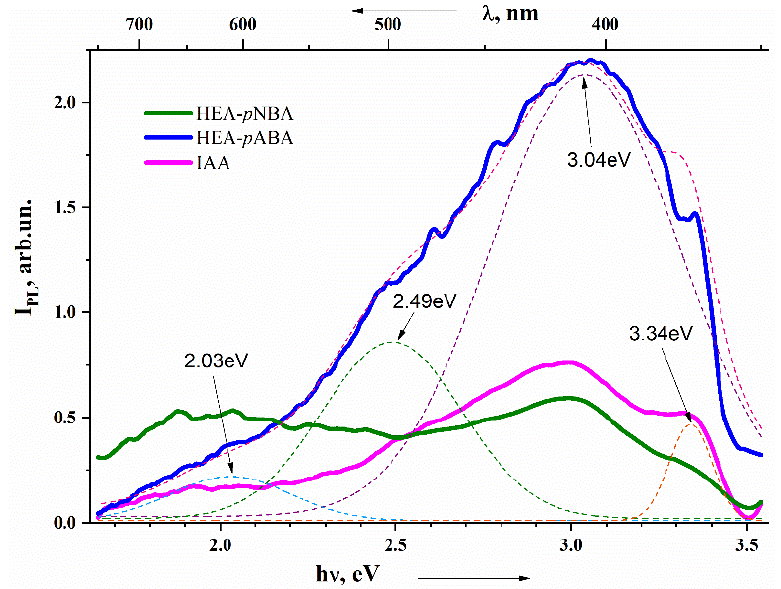
Figure 2. Emission spectra of HEA- p ABA and HEA- p NBA versus IAA. The deconvolution of Gaussian distribution functions are shown by thin dotted lines with the presentation of the maximum peaks in eV.